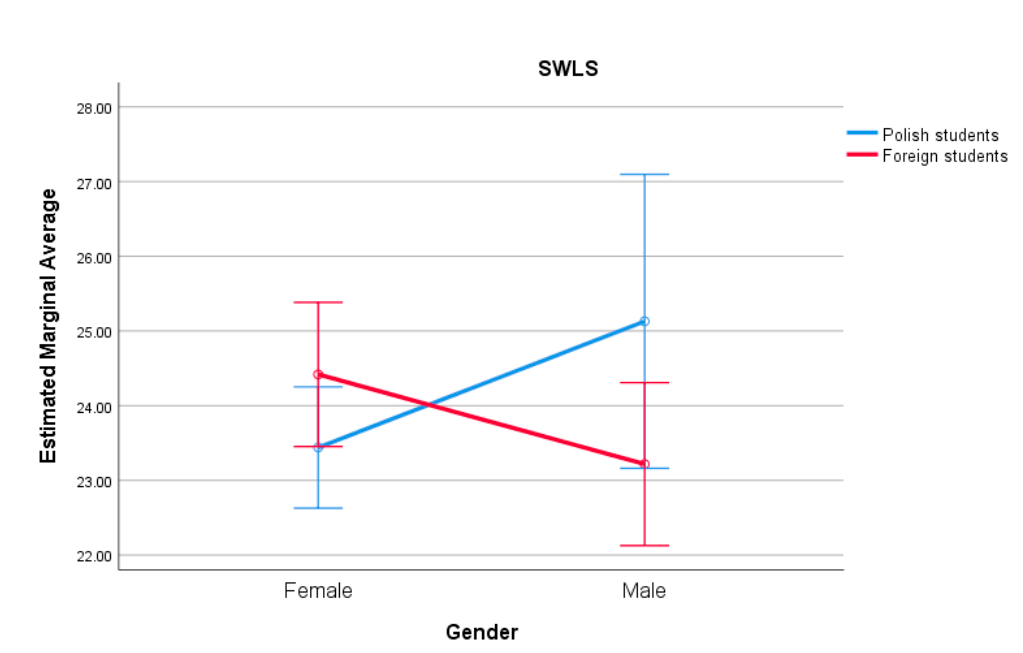
Figure 1. Means for SWLS by gender and nationality.